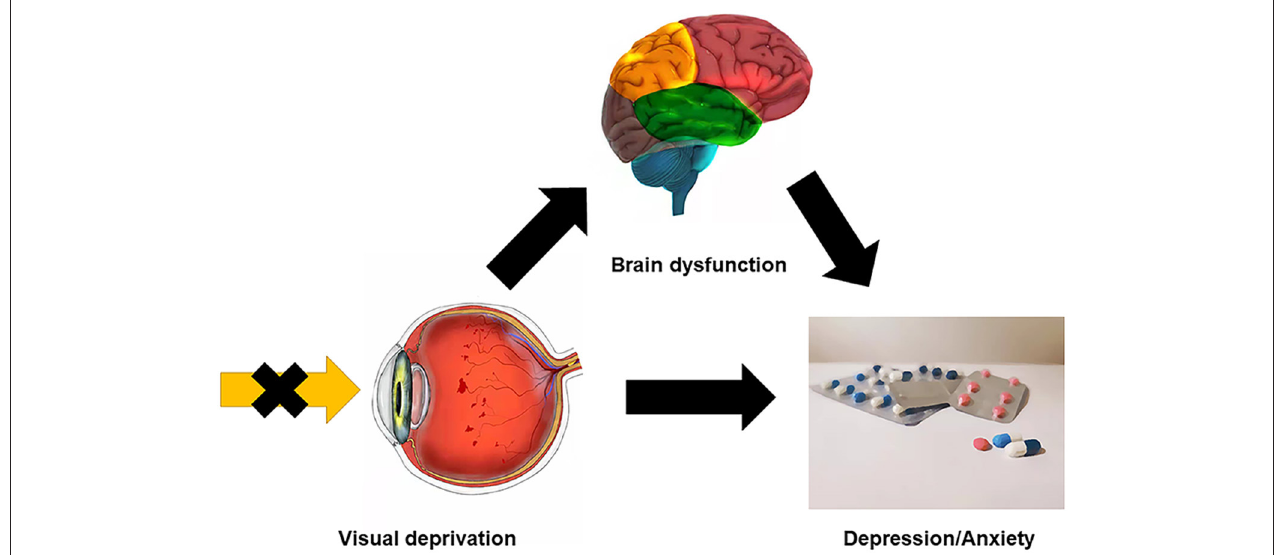
FIGURE 6 | Relationship between clinical manifestation, brain dysfunction, and psychological conditions of CB patients. CB patients could get certain brain region dysfunction because of visual deprivation, for example, the ReHo values were significantly decreased at MFG in CB patients, which could be relevant to anxiety and depression. And the visual disability itself may bring physiological or psychosocial problems, which make CB patients more susceptible to psychological disorders. CB, congenital blindness; MFG, middle frontal gyrus; ReHo, regional homogeneity.